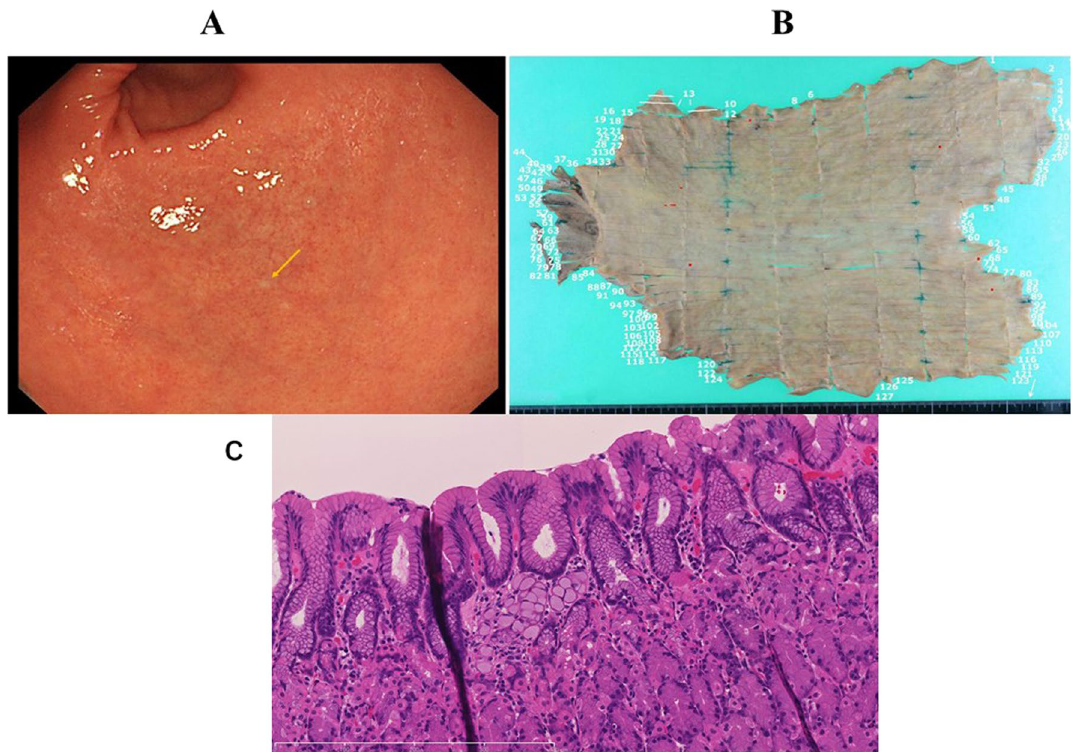
Fig. 2 Esophagogastroduodenoscopy, post-operative specimen and pathological findings in case III-2. Esophagogastroduodenoscopy revealed a type0-IIb lesion in the gastric pyloric zone. There was white spot area ( A , arrow). The gastrectomy mapping study revealed loca- tions of early gastric cancer ( B , red dots). The pathological examination showed intramucosal signet ring cell carcinoma ( C ×